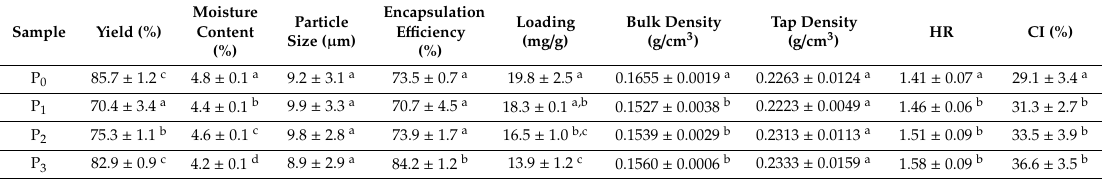
Table 1. Physical properties of powdered